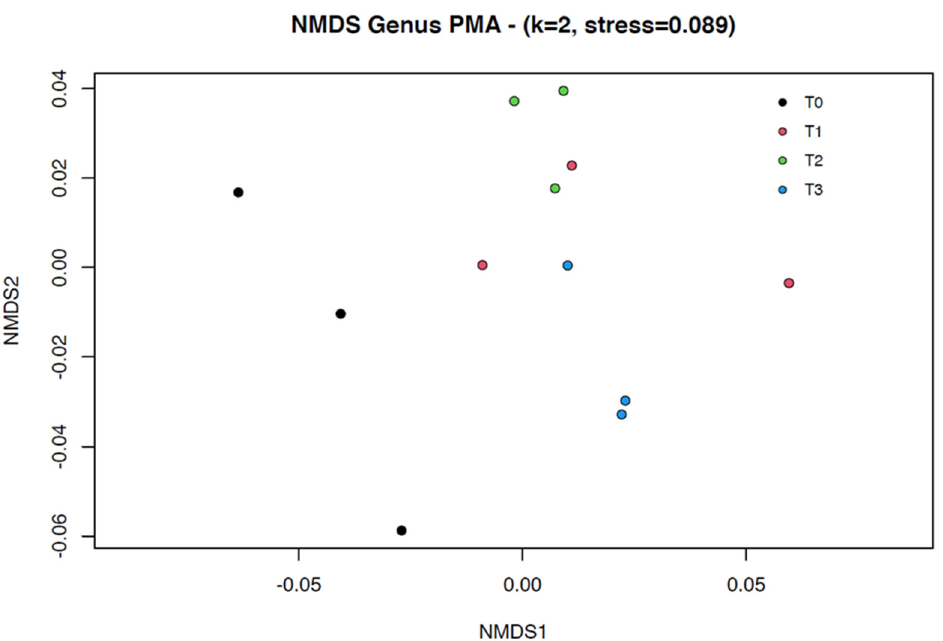
Figure 3. Nonmetric multidimensional scaling (NMDS) model (k = 2, stress = 0.089) based upon a Bray–Curtis dissimilarity matrix of the fecal microbial profiles before (black = fresh feces = T 0 ) and at the different steps of the fecal manipulation procedure (red = mixed feces = T1, green = prefiltered feces = T 2 , blue = final fecal filtrate = T 3 ). The 3 dots of each color represent the different subsamples (A, B, C). Despite global AMOVA analysis showing a heterogeneous variance between groups regarding β diversity ( p -value = 0.0008), a paired test did not reveal significant differences. HOMOVA testing yielded non-statistically significant differences.